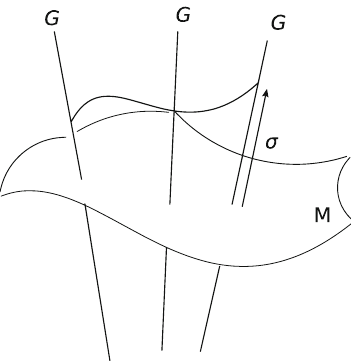
Fig. 1 Fibres G in the principal fibre bundle with base manifold M and section